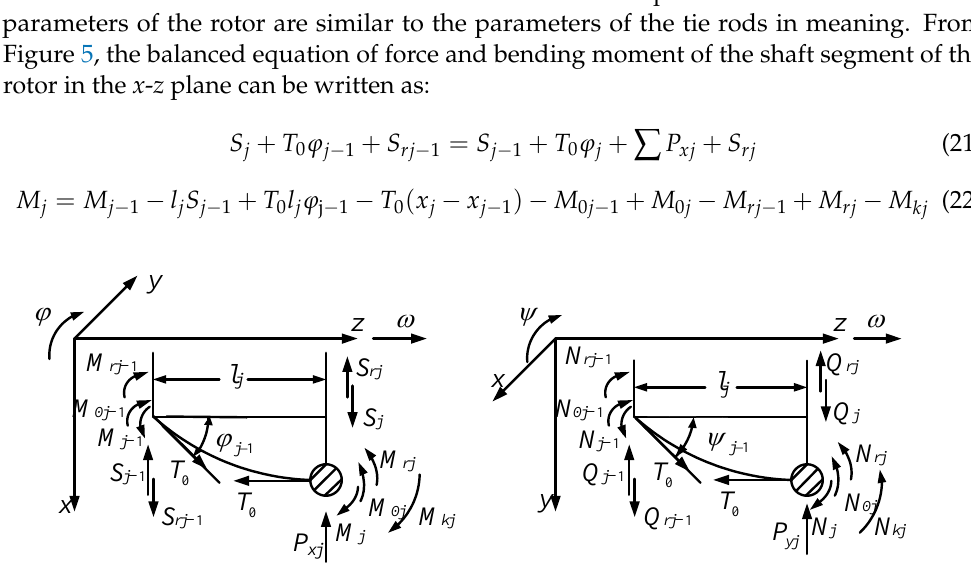
Figure 5. The force analysis of the j th fastened rotor shaft segment. In Equation (22), M 0 j = M j · 4 EA r r